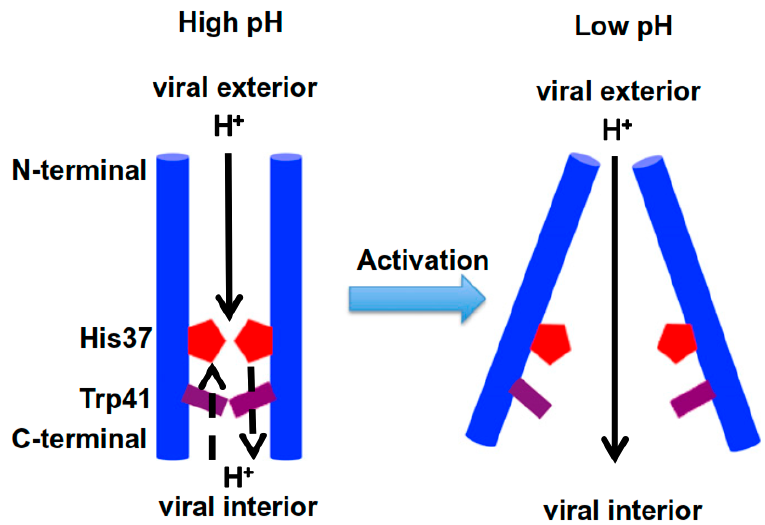
Figure 4. Model for AM2 channel acid activation and proton conductance displaying conformation change from closed to open conformers [148]. For clarity, only two helices and one protonation state are shown.